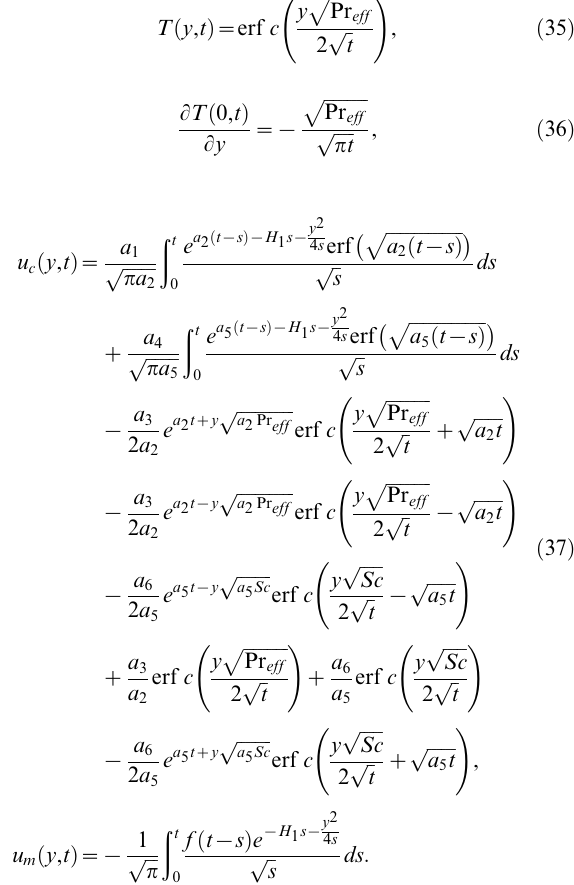
ffiffiffiffiffiffiffiffiffiffiffiffiffiffiffiffiffi a